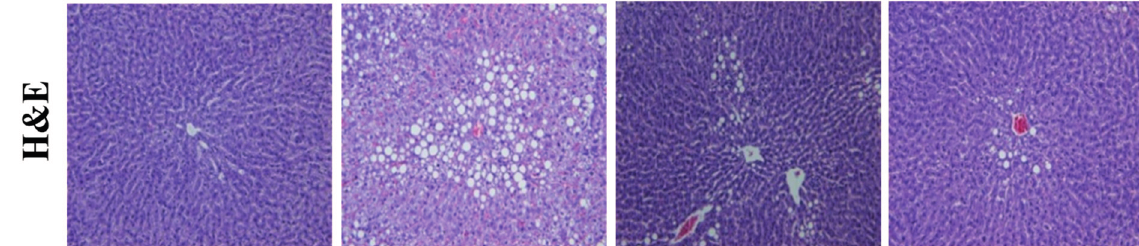
Figure 3. Confirmation of hepatic fatty liver in rats fed alcohol and KRG for 6 weeks. Hepatic histology: Oil Red O stained (upper panel) and H & E stained (lower panel). CON, normal control; ET, alcohol control; RGL, alcohol + 125 mg/kg KRG; RGH, alcohol + 250 mg/kg KRG. Alcohol was provided at 5% of the Lieber-DeCarli liquid diet, and KRG was administered daily by gavage for the same time period. Data are expressed as the means ± SE ( n = 10/group).